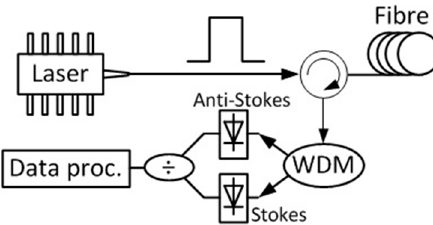
Figure 4. Simple scheme of a distributed Raman sensor. An intense pulse is launched into the fibre; then, the Stokes and anti-Stokes components of Raman scattering are selected by a wavelength division multiplexer (WDM) and acquired by two photodetectors. Their power ratio is obtained and processed.